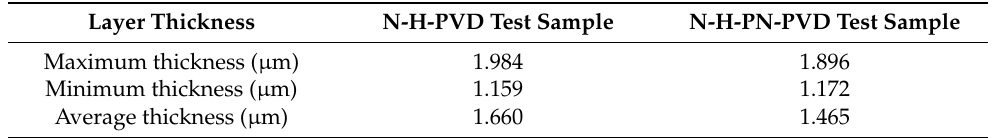
Figure 7. The cross-section microscopy of Nital etched ( a ) N-H-PVD test sample and ( b ) N-H-PN- PVD test sample. Table 5. Surface layer thicknesses of N-H-PVD and N-H-PN-PVD